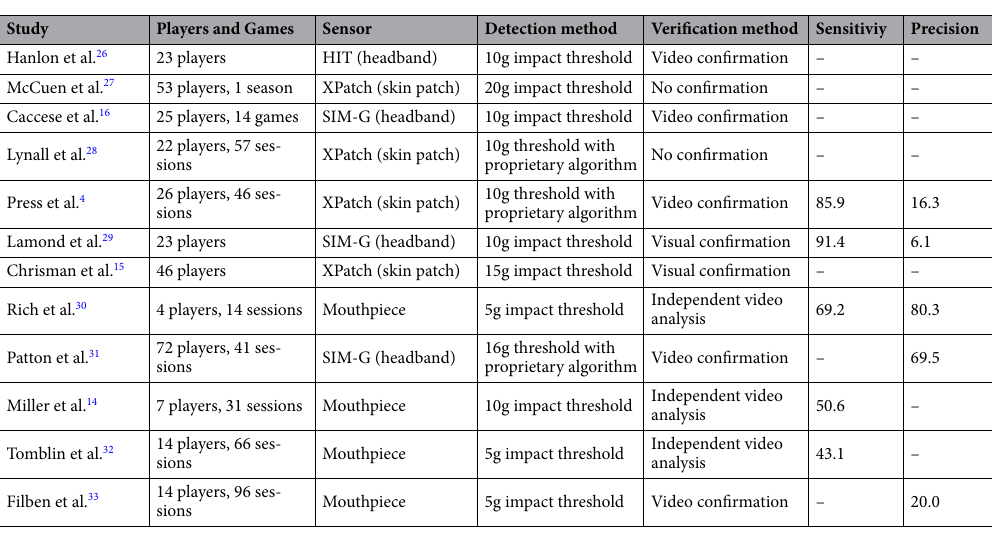
Table 1. Previous head impact exposure studies in